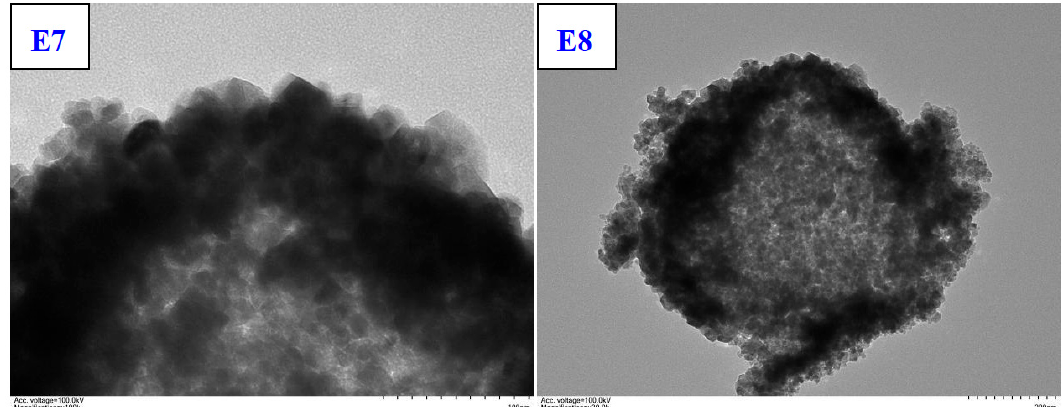
Figure3. Scanningelectronmicroscopy(SEM)imageswithdi ff erentmagnificationsof( A1 , A2 )diatomite, Figure 3. Scanning electron microscopy (SEM) images with different magnifications of ( A1 , A2 )